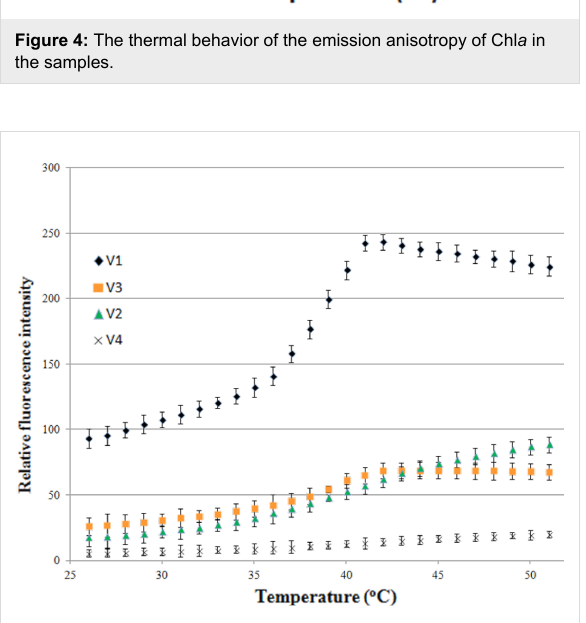
Figure 5: The variation with temperature of the maximum of the rela- tive fluorescence intensity of Chl a in the